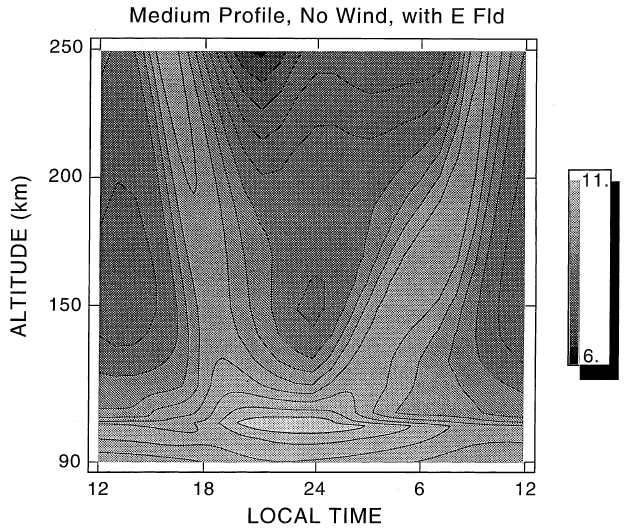
Fig. 5. Height versus local time contours of log from the 1-D version of the model, and driven by vertical drifts due to the electric field only. Minimum contour is 6.0 ( black ) and maximum contour is 12.0 ( white ), with spacing of 0.25 and concentrations given in m )